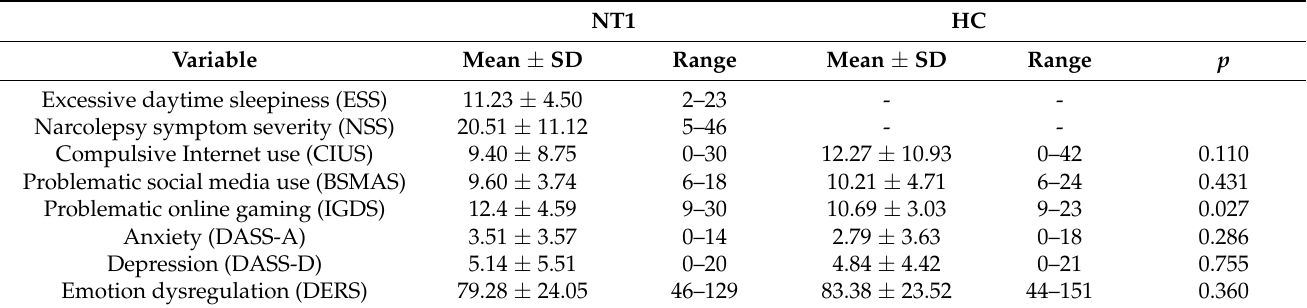
Table 1. Clinical characteristics of NT1 and HC group.